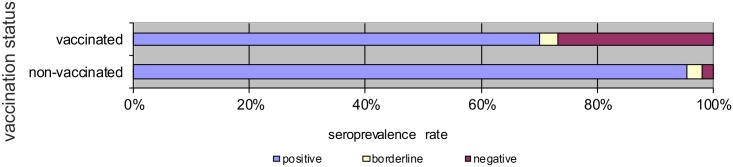
Prevalence of IgG antibodies against measles in group 40–49 years of age.